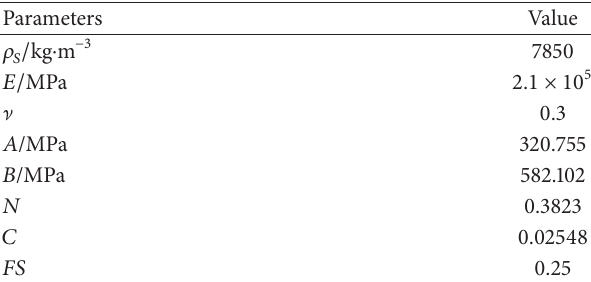
Table 1: Steel material